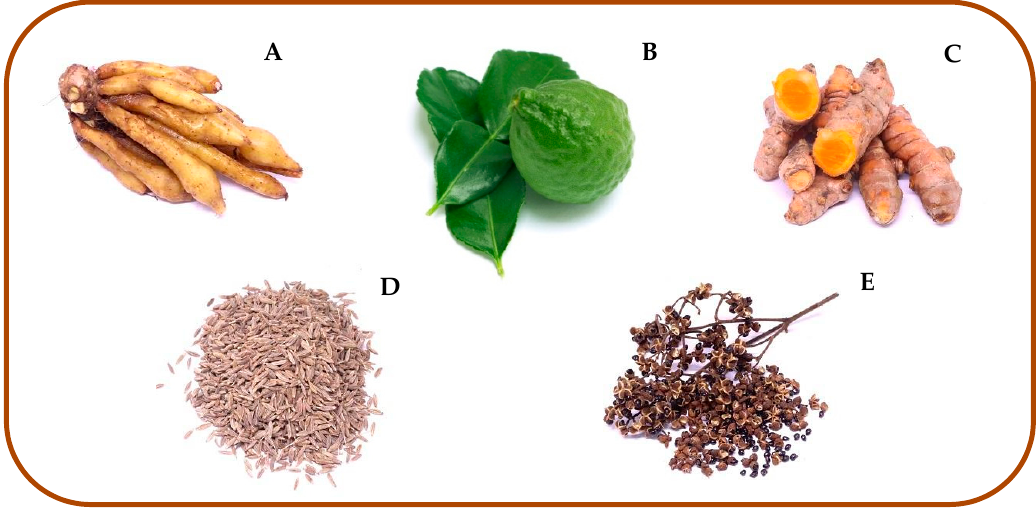
Figure 1. Plant material of B. rotunda ( A ), C. hystrix ( B ), C. longa ( C ), O. gratissimum ( D ), and Z. limonella